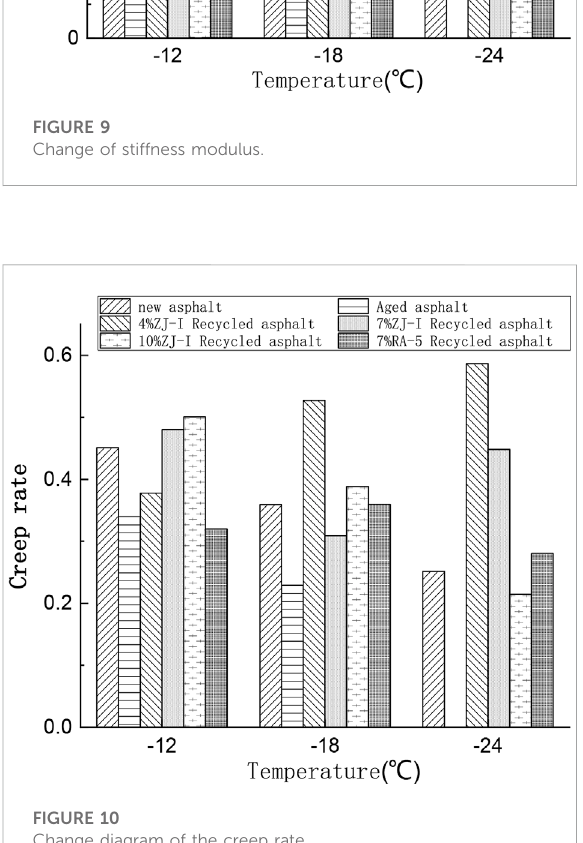
FIGURE 10 Change diagram of the creep